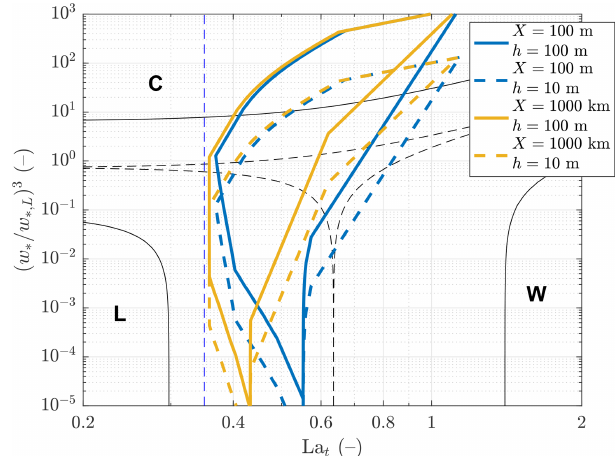
Figure 2. Regime diagram for OML mixing following Belcher et al. (2012). Continuous black lines delineate regions where at least 90% of the total TKE is dissipated by only one of the three processes: Langmuir turbulence, wind shear, or convection (letters L, W, and C, respectively). Similarly, dashed black lines mark regions where TKE dissipation due to one process exceeds 50% of the total dis- sipation. The thin dashed blue line is located at La t = 0 . 35, cor- responding to fully developed waves. When the (La t , w 3 ∗ /w 3 ∗ pairs are computed for a range of wind, air temperature, and wave conditions described in the text, the corresponding points fall into a region marked with a color contour, the exact position and shape of which depends on the assumed value of the mixed layer depth h (continuous lines: h = 100m; dashed lines: h = 10m) and fetch X (blue: X = 100m; yellow: X = 1000km). See text for more